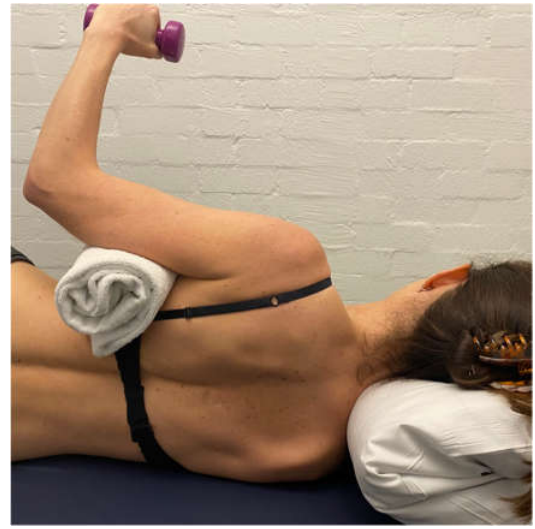
Figure 7. Side-lie external rotation.